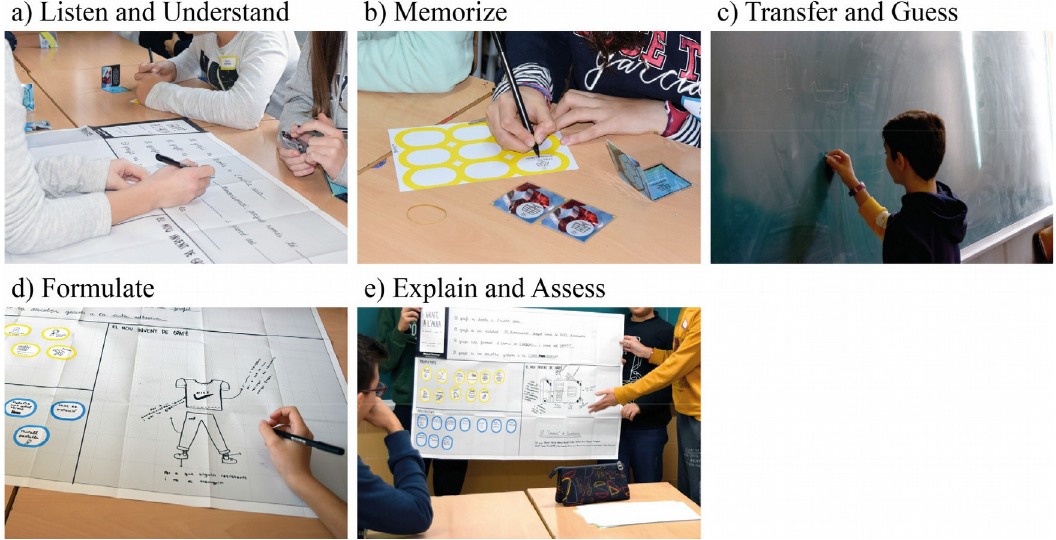
Figure 2. Photos of the workshop “Graphene in the